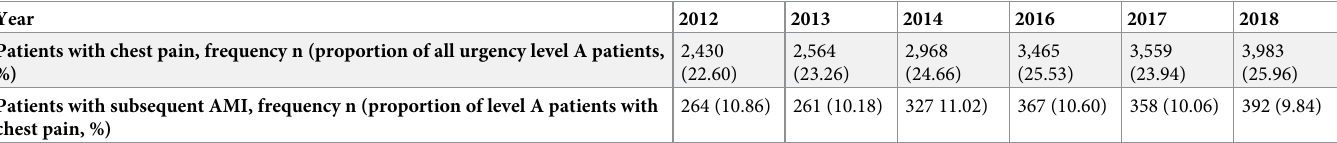
Table 2. Trends in number of patients with chest pain as main complaint and subsequently acute myocardial infarction diagnosis. AMI, acute myocardial